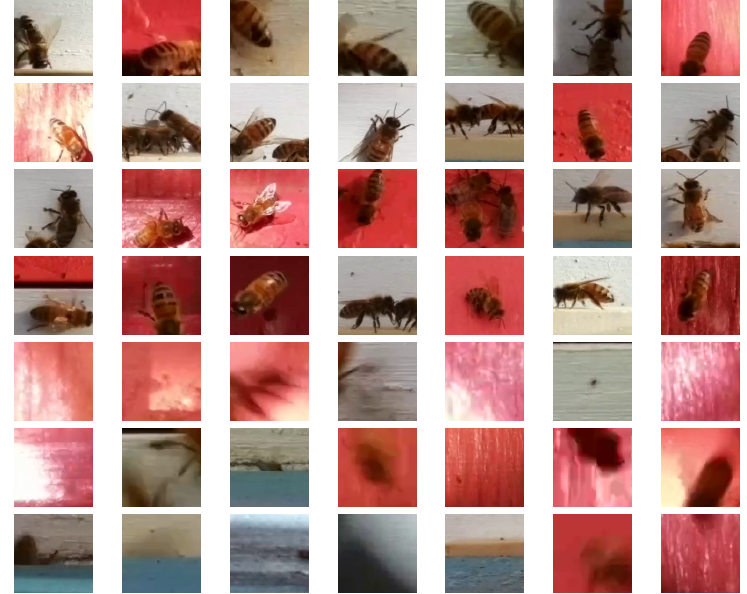
Figure 7. A sample of 1-super images from BEE2 (BEE2_1S). The first four rows include images classified as BEE. The last three rows consist of images classified as